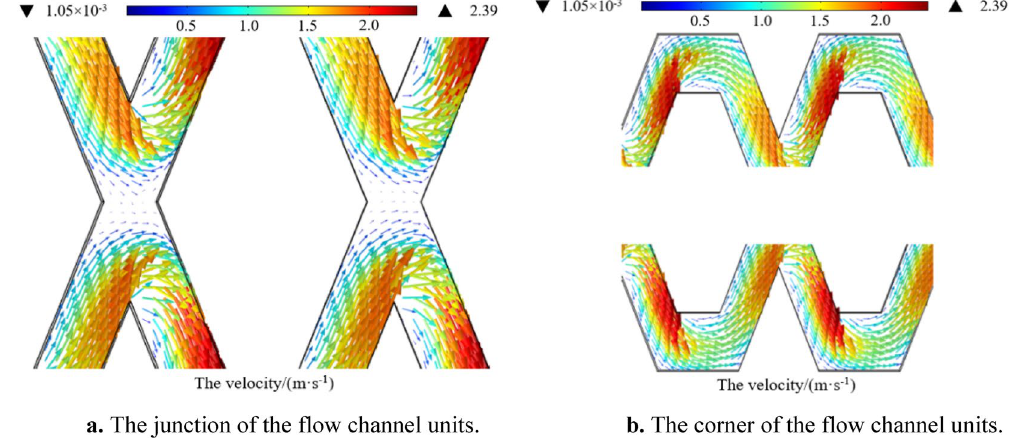
Figure 8. ( a ) The junction of the flow channel units. ( b ) The corner of the flow channel units.